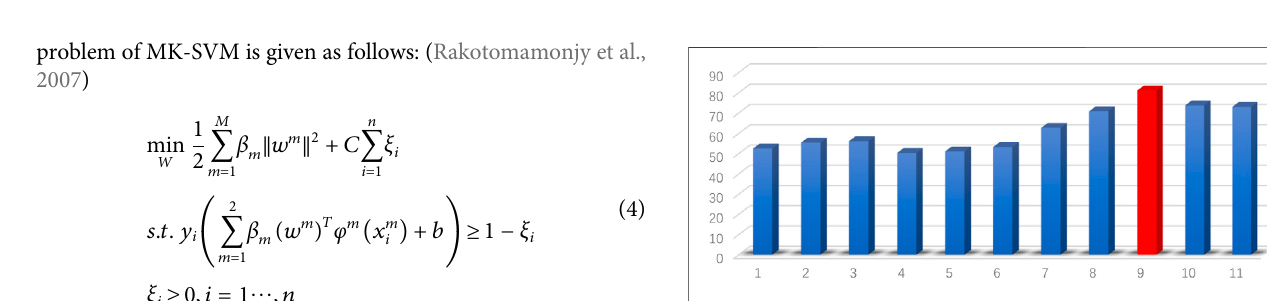
FIGURE 1 | The entire framework of the proposed method for combining multiple connection patterns.